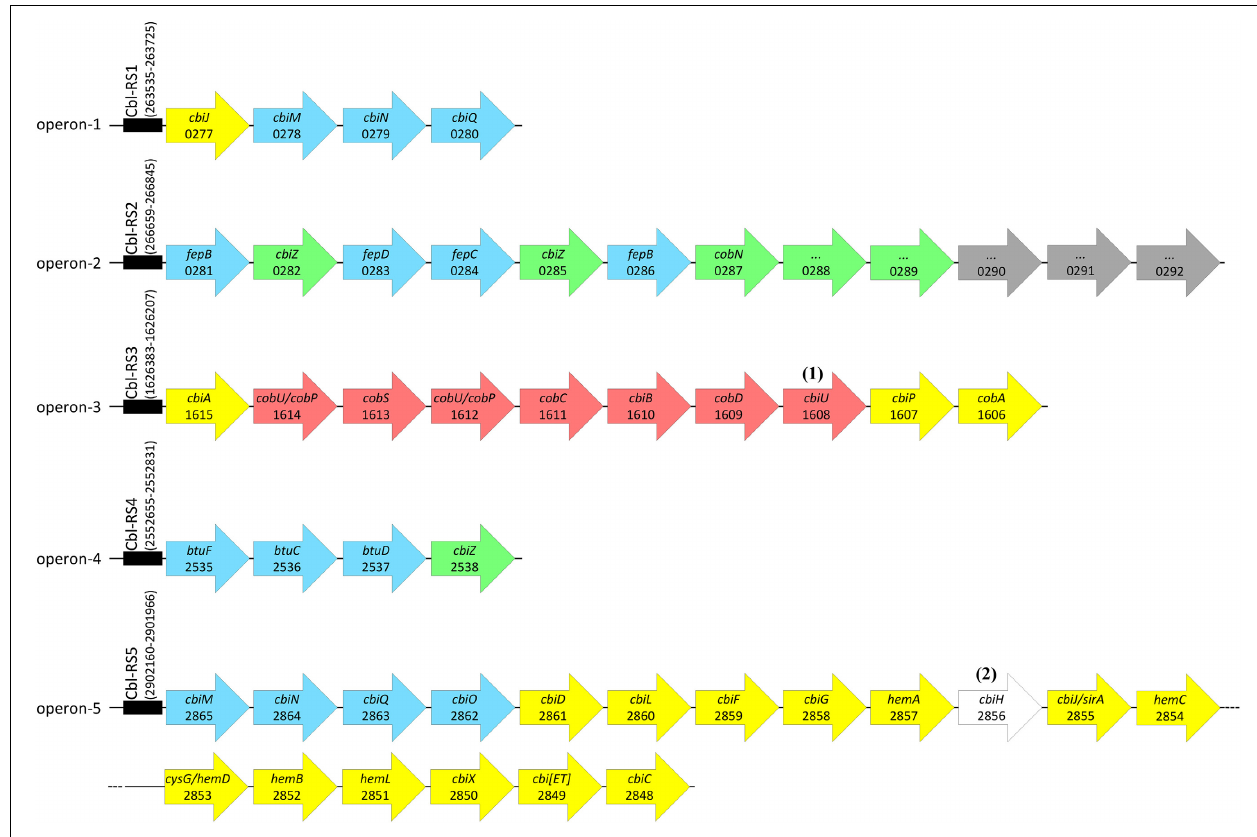
FIGURE 3 | Arrangement of genes associated with corrinoid biosynthesis and uptake in the genome of D. restrictus . Genes involved in corrinoid metabolism are grouped in five operons (operon-1 to -5) located in different places of the genome. All five operons are predicted to be regulated by cobalamin riboswitches (Cbl-RS1 to -5, indicated by a black box) located directly upstream of the first gene of each operon. Cbl-RS coordinates are given based on their identification by Rfam. Genes are depicted as arrows in colors corresponding to four